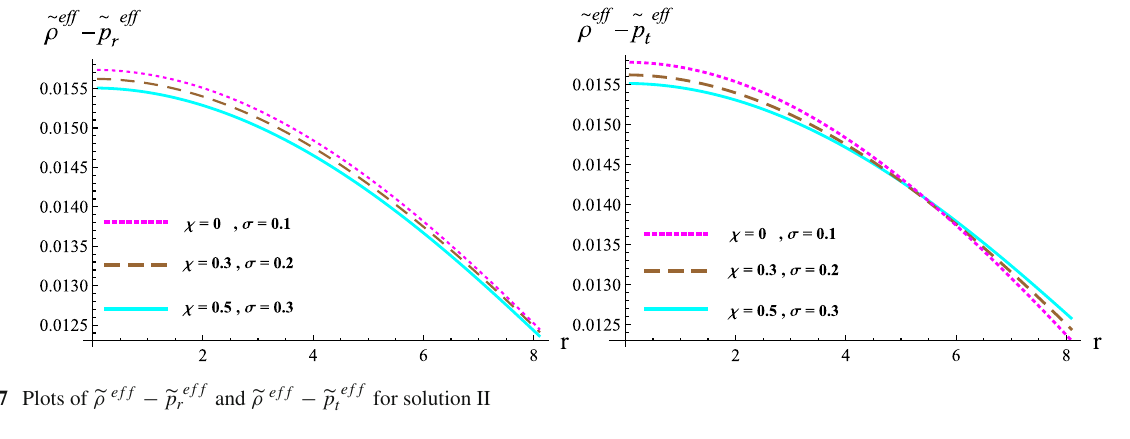
Fig. 7 Plots of (cid:5) ρ ef f − (cid:5) p ef f r